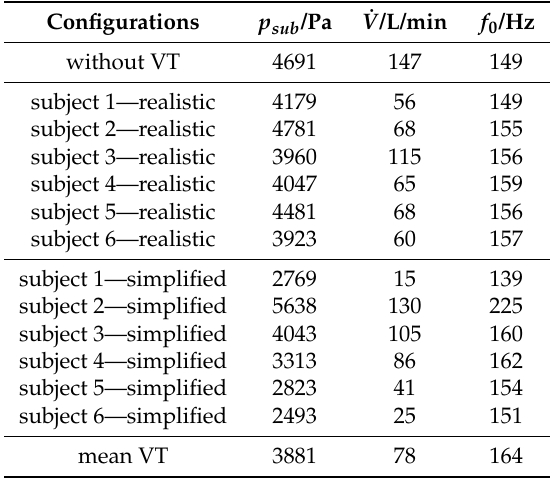
Table 1. Physical parameters of the mean subglottal pressure p sub , the volume flow rate ˙ V , and the fundamental oscillation frequency f 0 as measured in our experimental